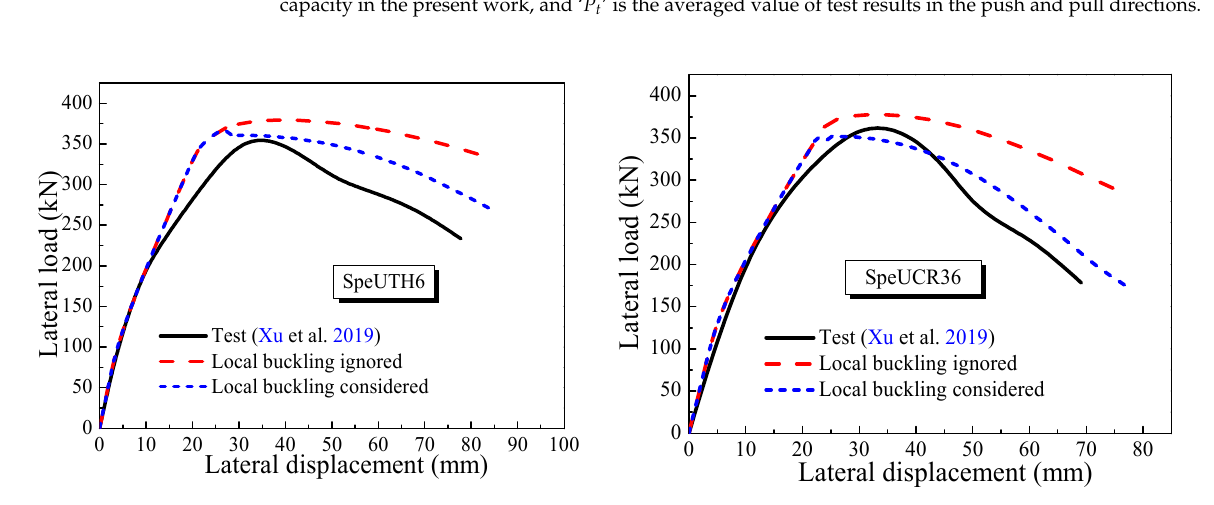
Figure 11. Calculations of the UHPCFST specimens SpeUTH6 and SpeUCR36 [31]. The lateral load–displacement hysteretic curves of the test, and which were predicted by the fiber element model with the local buckling considered, are shown in Figure